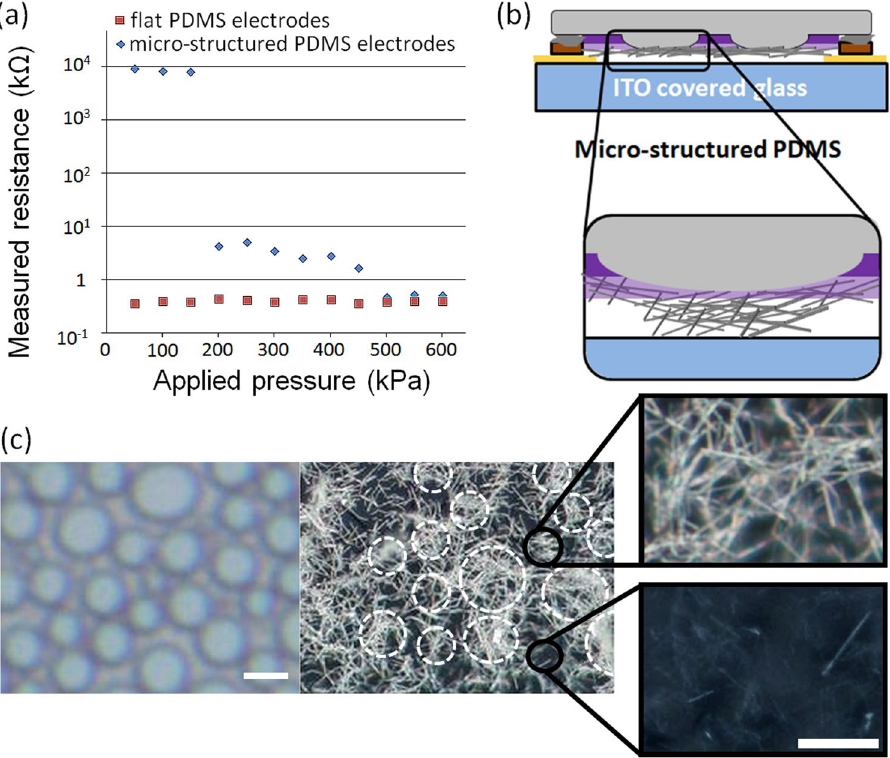
Figure 1. ( a ) Pressure sensitive response of PEDOT:PSS/AgNWs/PEDOT:PSS deposited on flat and micro- structured PDMS; ( b ) Schematic representation of the micro-structured PDMS electrodes and ( c ) Optical micrographs of micro-structured PDMS before and after deposition of PEDOT:PSS/AgNWs/PEDOT:PSS and zoomed areas (right) corresponding to high- (top) and low-AgNWs (bottom). Scale bars of left and right images correspond to 2 μ m and 500 nm,